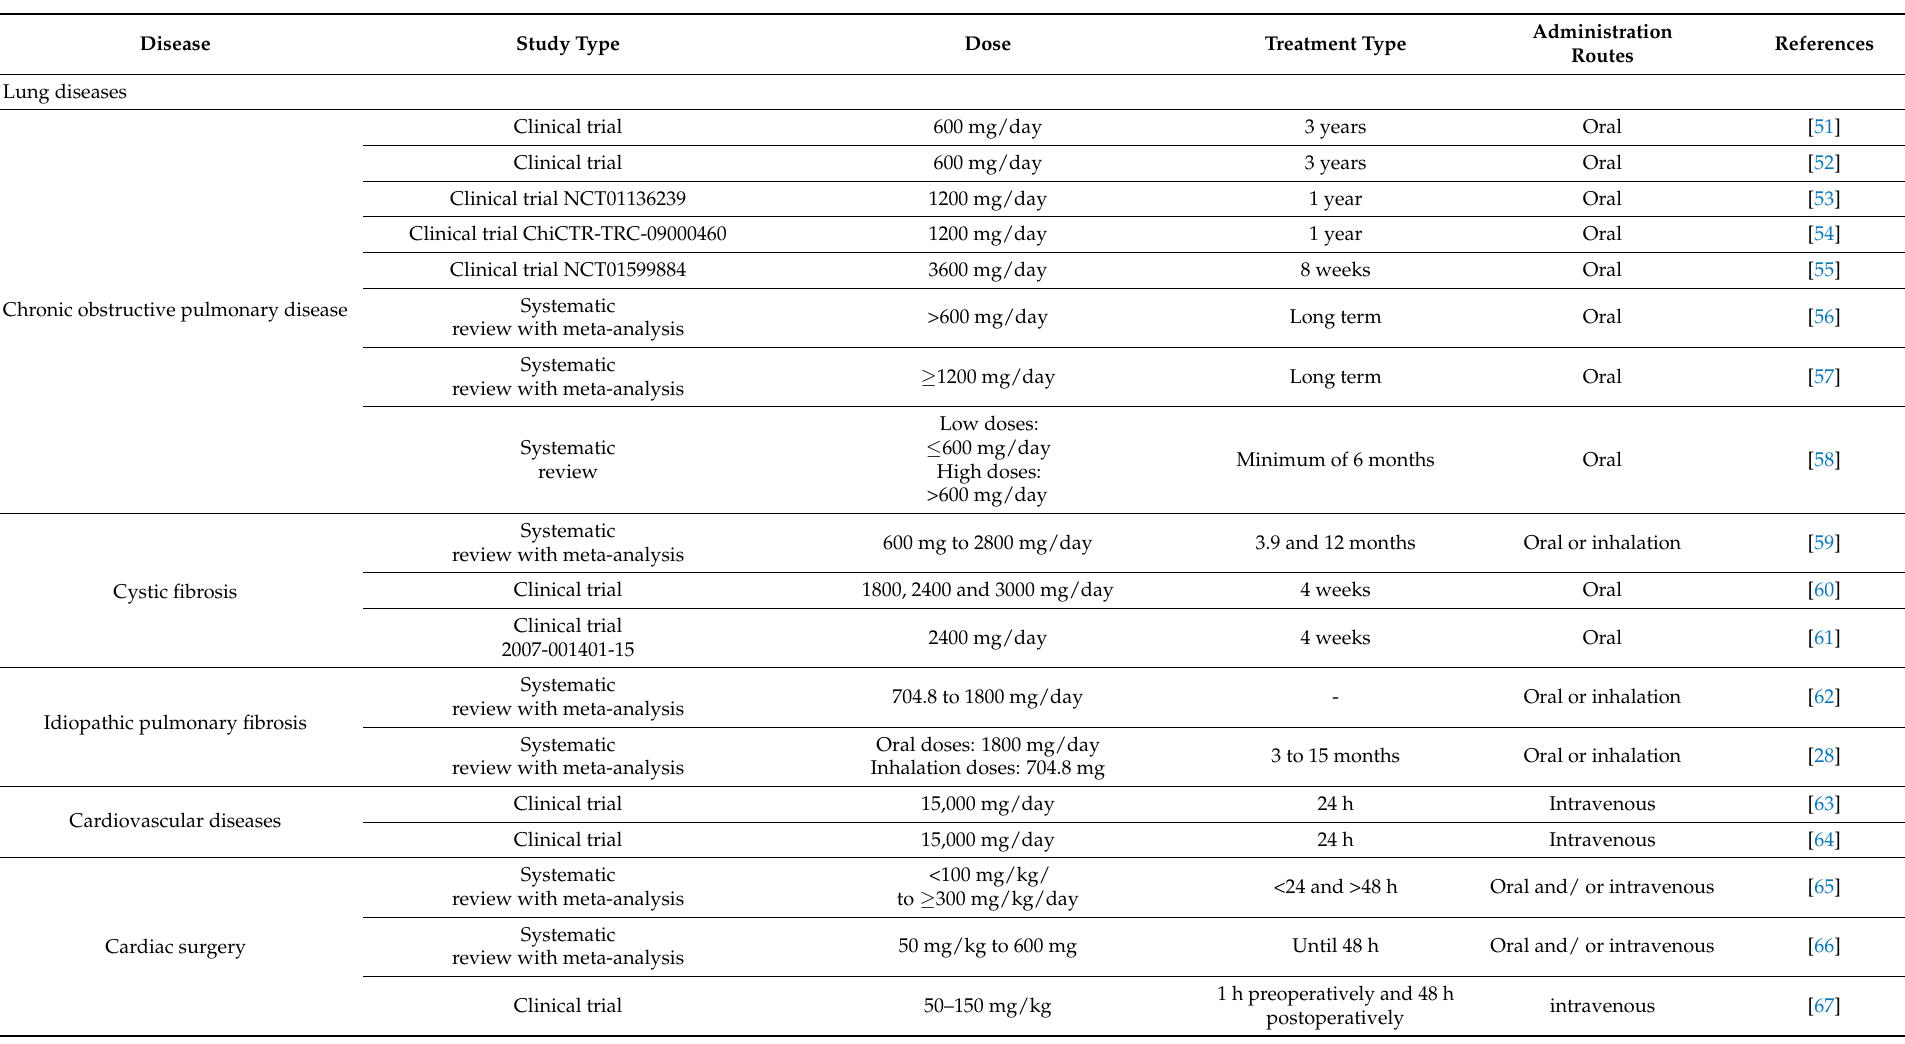
Table 2. Studies carried out with N -acetylcysteine in different clinical